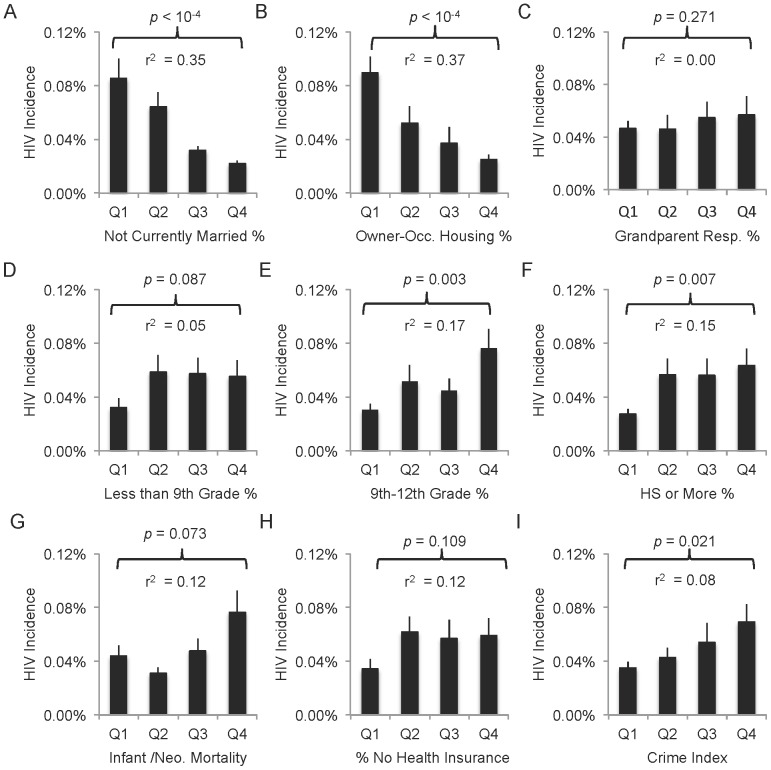
Examples of possible degrees of population-level HIV/socioeconomic associations.Cities were sorted by various 2000 population metrics (x-axes), and the HIV incidence averaged over quartiles, where Q1 represents the average HIV incidence for the 20 cities with the highest values for that census metric and Q4 the average HIV incidence in the 20 cities with the lowest values for that census metric. T-test comparison of the HIV values in first and fourth quarters illustrates that many metrics are associated with HIV incidence (A, B, E, F, I), while others weakly associate (D, G, H) and still others are not likely to be associated (C). Bars = SEM.